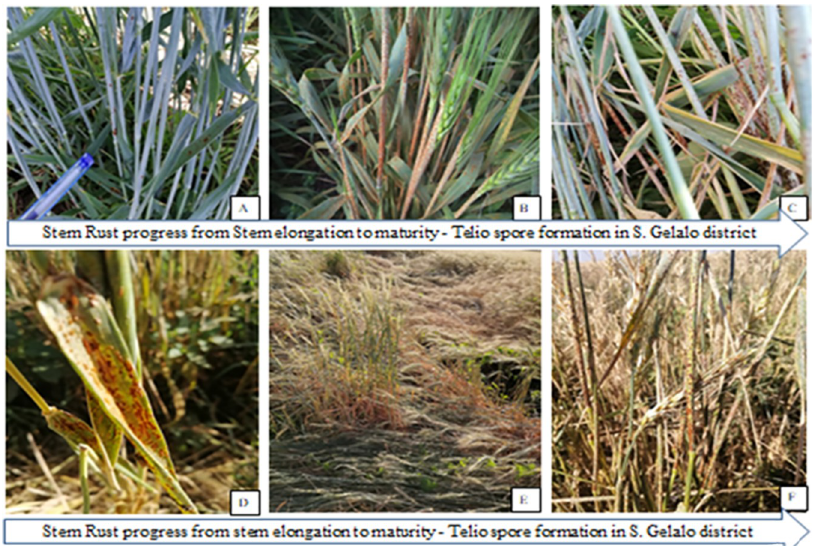
Fig 2. Stem rust virulence progress in a different stage of the plant: (A = stem elongation, B = Booting stage, C = milky stage, D = dough stage, E = matured, F = teliospore formed in straw) districts of S. Gellalo districts.